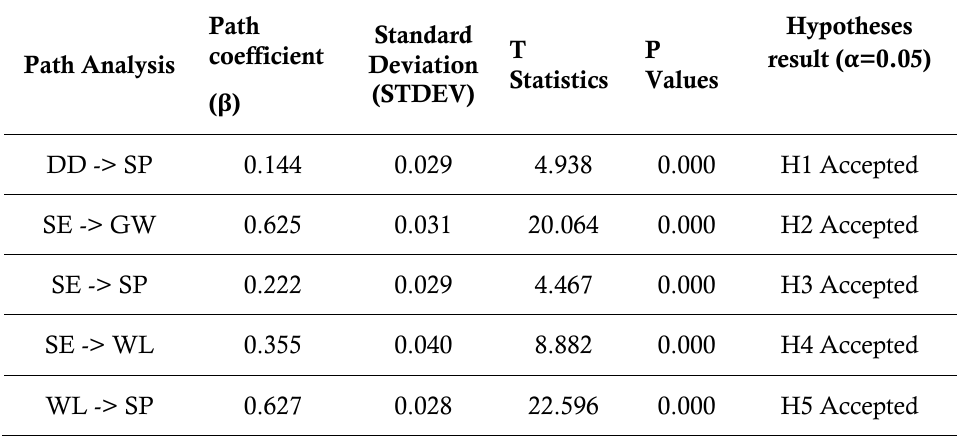
Table 6. Summary of path analysis results and hypothesis